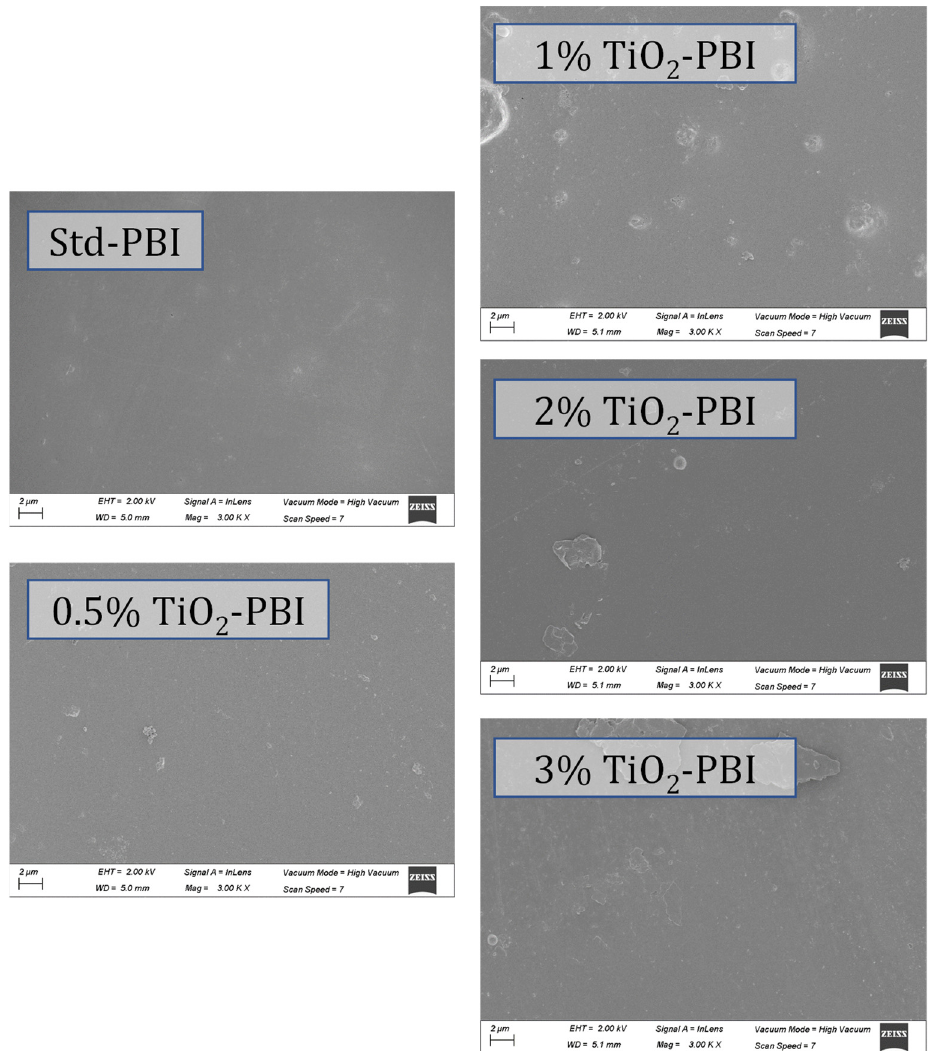
Figure 2. Surface SEM images for the standard and composite membranes .